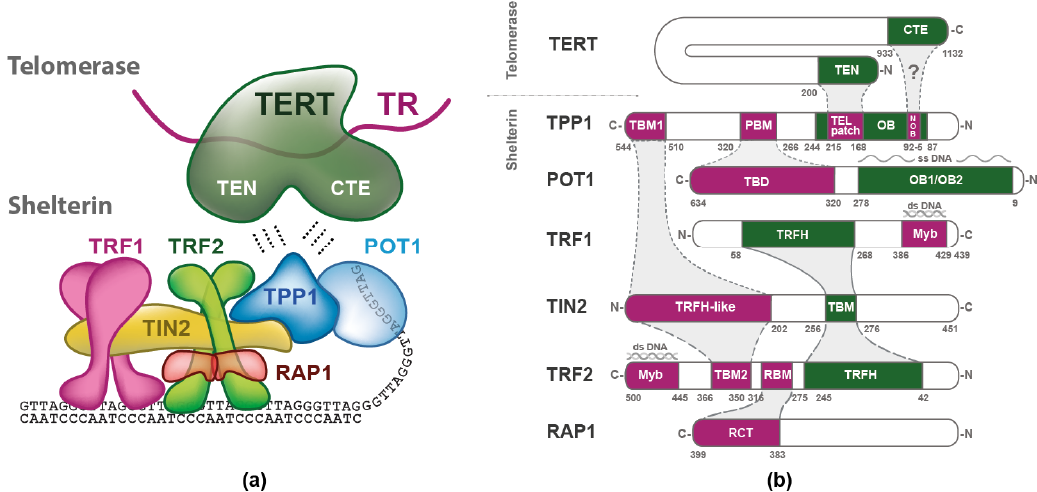
Figure 1. Arrangement and interaction domain map of shelterin and telomerase: ( a ) Schematic description of telomerase and shelterin subunits. TERT is the catalytic subunit with telomerase essential N ‐ terminal (TEN) domain and C ‐ terminal extension (CTE) domain, TR is the RNA subunit of telomerase. Shelterin subunits TRF1, TRF2, and RAP1 are shown as dimers, and the other shelterin subunits are illustrated as monomers. ( b ) The interaction map of the telomerase TERT subunit and the six human shelterin subunits are depicted. The Myb/SANT domains of TRF1 and TRF2 recognizing double ‐ stranded DNA are indicated with Myb. The OB1/OB2 domain of POT1 recognizing single ‐ stranded DNA. TBD is the TPP1 binding domain of POT1. PBM is POT1 binding motif of TPP1. The OB domain of TPP1 contains two regions: the TEL patch that binds TEN domain of telomerase and the NOB region that probably binds CTE domain of telomerase, denoted by “?” [9]. TBM of TIN2 binds the TRFH domain of TRF1 and TRF2. TBM1—TIN2 ‐ binding motif of TPP1, TRFH—dimerization domain of TRF1 and TRF2, TRFH ‐ like—TIN2 domain that binds TPP1 and TRF2; TBM2 binds TRFH ‐ like binding motif of TIN2, and TBM2—TIN2 ‐ binding motif of TRF2. RBM—RAP1 binding motif of TRF2. RCT is the RAP1 C ‐ terminal domain that binds RBM of TRF2. The more solid the outline between the interacting domains, the higher their mutual affinity